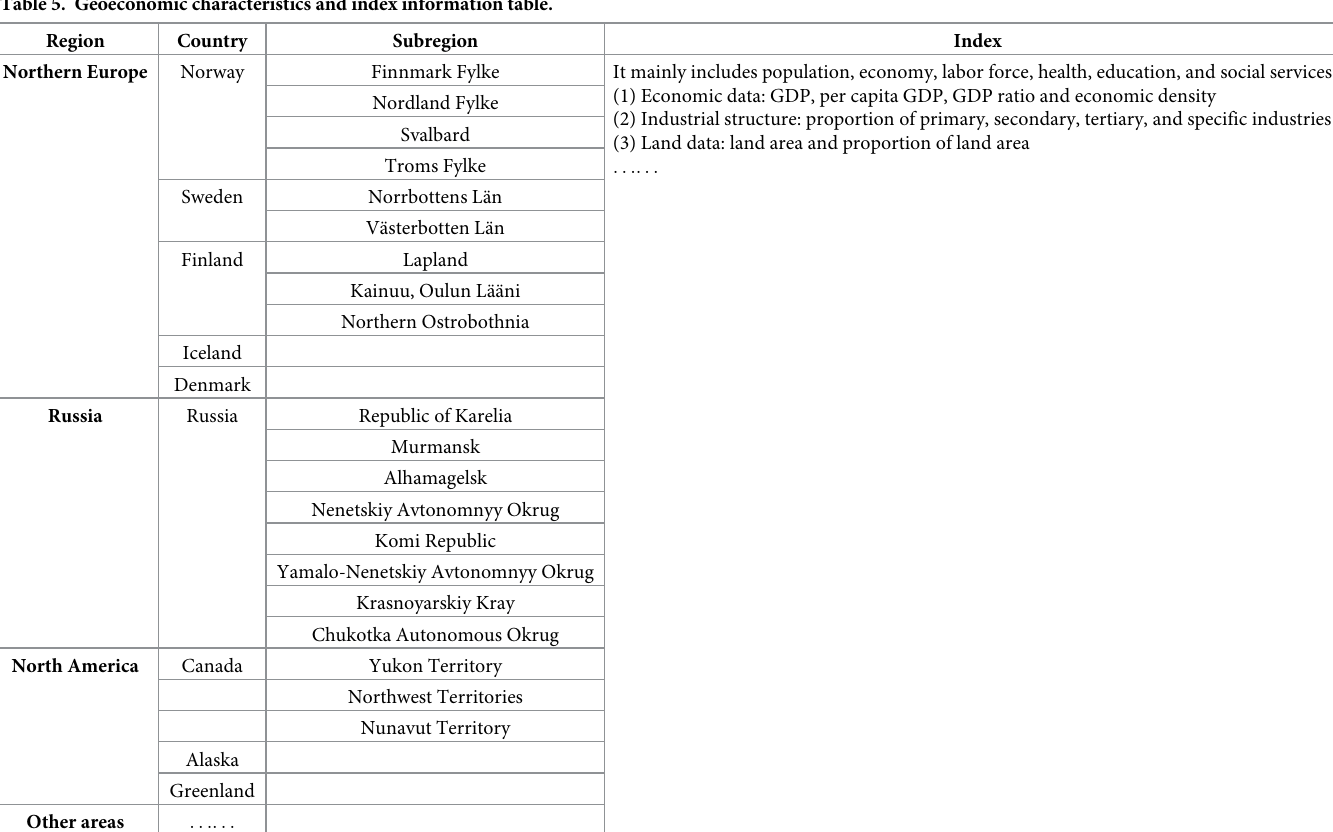
Table 5. Geoeconomic characteristics and index information